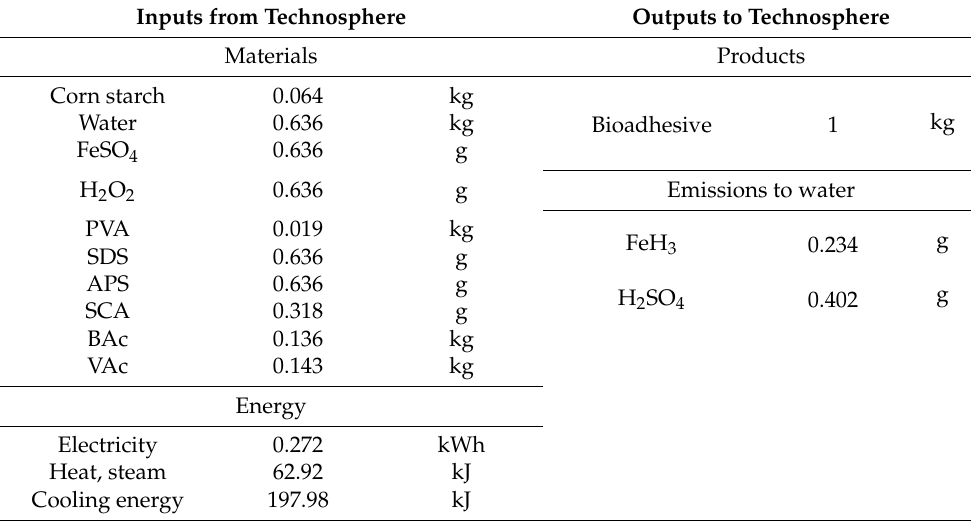
Table 3. Inventory data for the production of starch bioadhesive oxidized with FeSO 4 and H 2 O 2 (Alternative 3). Detailed data per functional unit (1 kg of bioadhesive). Acronyms: polyvinyl alcohol (PVA), sodium dodecyl sulfate (SDS), ammonium persulfate (APS), silane coupling agent (SCA), vinyl acetate (VAc), butyl acrylate